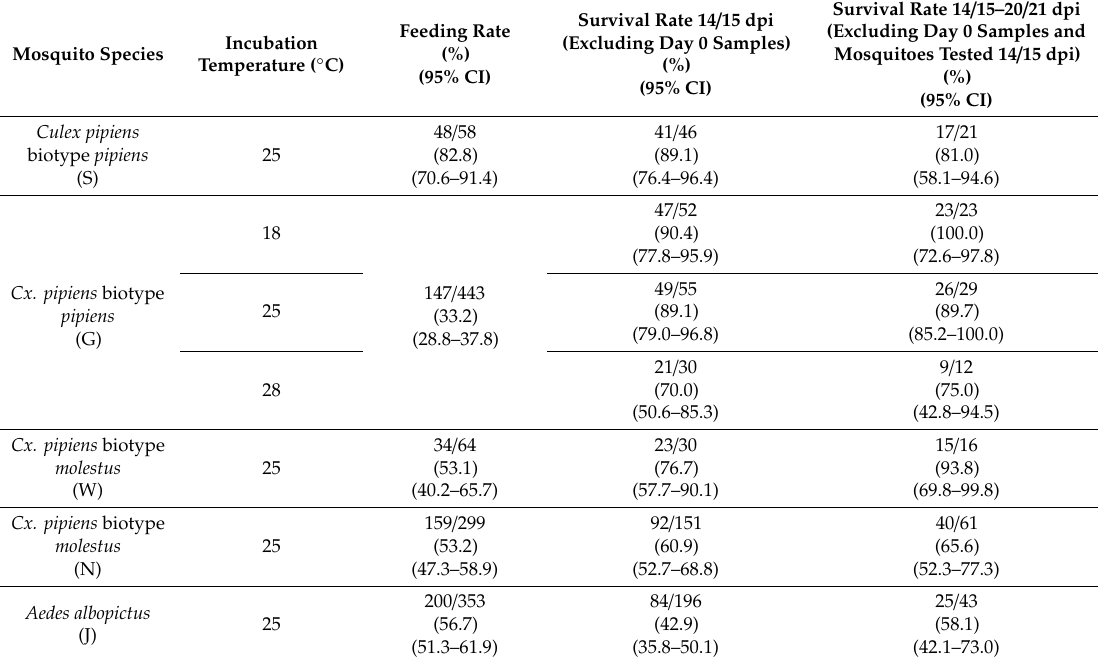
Table 2. Mosquito feeding and survival rates, up to 14 / 15 days post infection (dpi) and 14 / 15–20 / 21 dpi, with German West Nile virus lineage 2 at di ff erent temperatures. CI stands for confidence